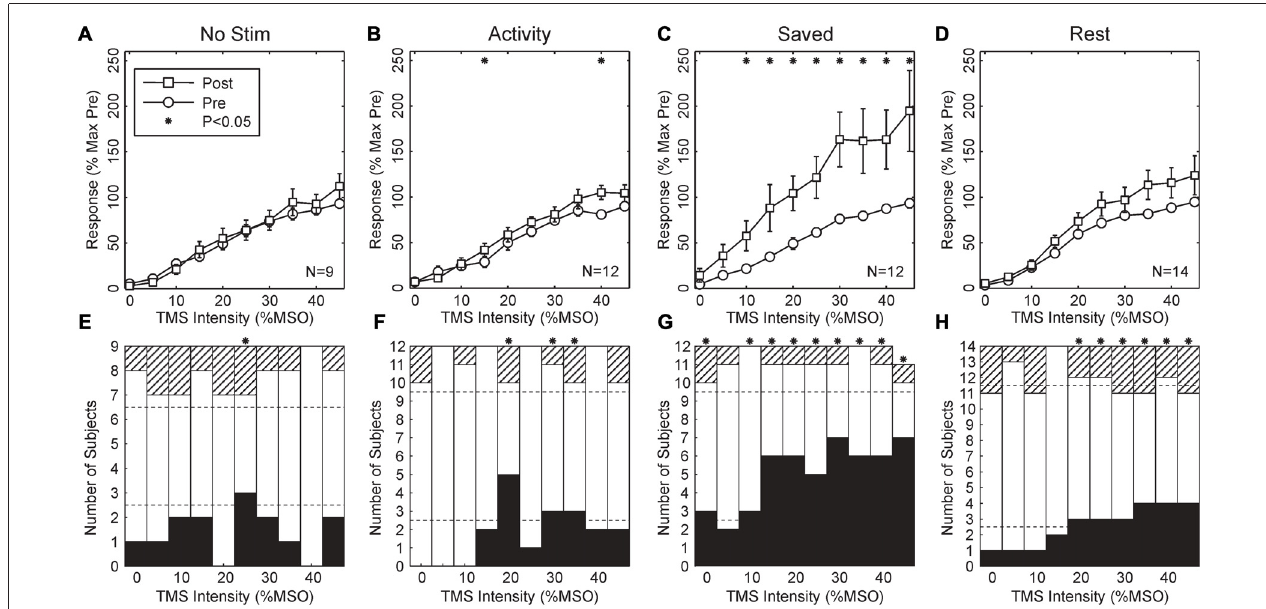
FIGURE 3 | Population results across all subjects. (A–D) Averaged MEP recruitment curves for the conditions indicated above each plot. Circles indicate curves measured in the morning before wearable device use, squares indicate curves measured in the afternoon after the device had been worn. Each point is the mean ± SEM calculated across subjects. Intensities have been normalized by subtracting the first intensity with a response significantly different from zero in each subject. Responses are expressed as a percentage of the maximum response seen in the morning recordings for each subject. Subject numbers (N) are shown inset to each plot. (E–H) Bar charts showing the number of subjects with significant changes in their recruitment curves at each intensity. Black bars mark subjects with significant increases after wearable device use; hatched bars show subjects with a significant decrease; white bars, no change. Dotted lines indicate thresholds, based on the binomial distribution. On the null hypothesis, both black and hatched bars should remain within these lines. Asterisks throughout mark results with significant changes before and after wearable device use ( P <